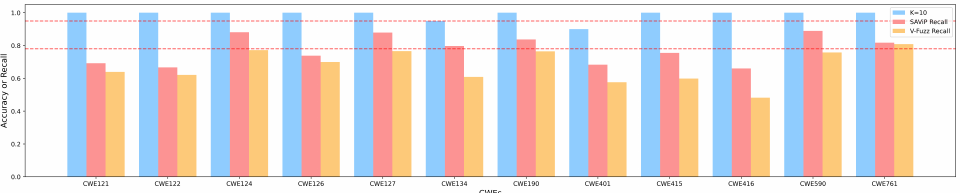
Figure 7. Performance comparison of SAViP and V-Fuzz. For both the Top-K accuracies and recall, SAViP performs better than V-Fuzz.